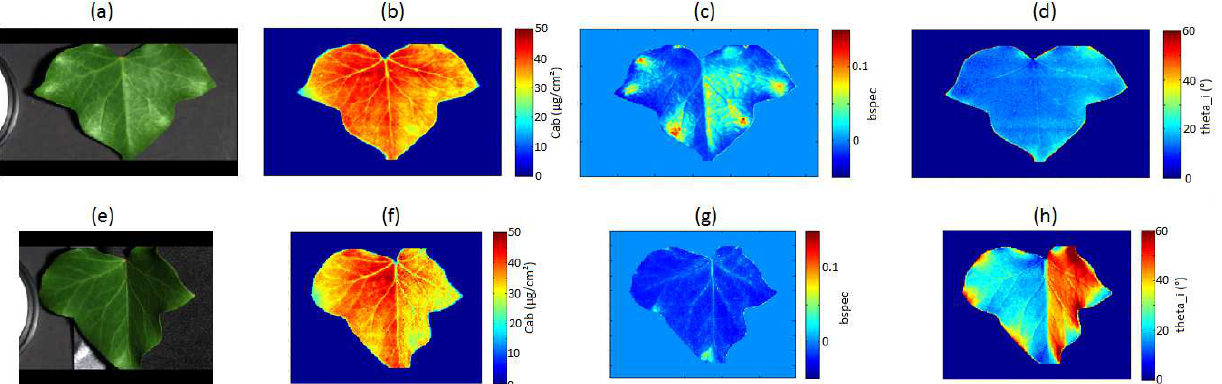
Figure 2: Estimated maps obtained with the radiance model and on the same leaf in flat (a-d) and 40 o tilted (e-h) positions: (a) and (e) RGB images, (b) and (f) C ab estimated maps, (c) and (g) b spec estimated maps, (d) and (h) θ i estimated